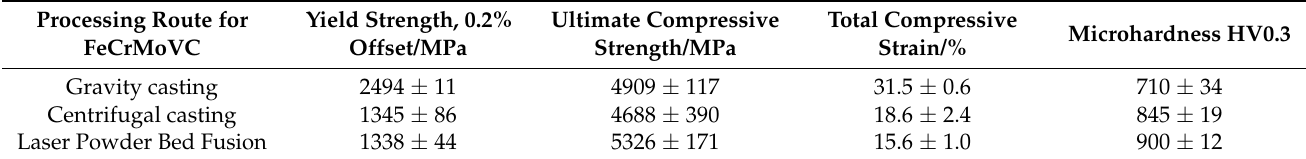
Figure 4. Representative room temperature engineering compression stress–strain curves of the Fe85Cr4Mo8V2C1 processed by gravity casting, centrifugal casting and laser powder bed fusion. Table 2. Engineering values of room temperature compression tests and microhardness for Fe85Cr4Mo8V2C1 samples processed by gravity and centrifugal casting as well as by laser powder bed fusion.